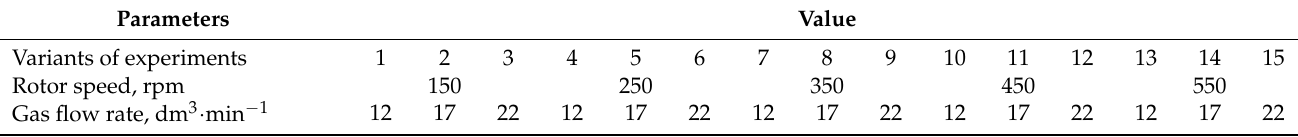
Table 2. Process parameters used in modeling